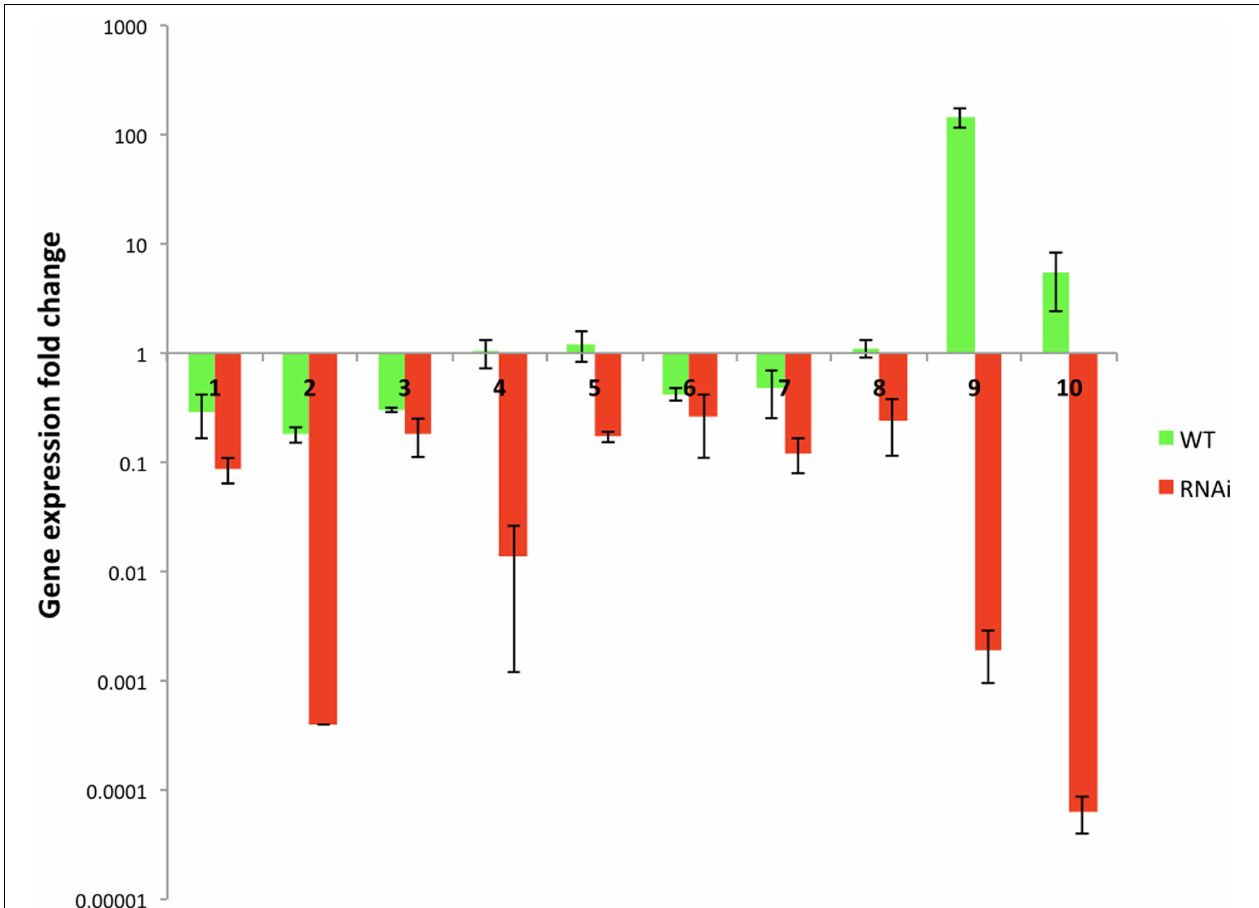
FIGURE 7 | The target genes expression studies of the transformants of RNAi and wild type strain carrying antisense gene library plasmids. Y -axis – logarithmic scale. RNAi strain was Y1662, and the wild type was Y1637, which were newly re-transformed with plasmids. Antisense plasmids: 1 – 2C23 (CAGL0L00157g gene), 2 – 2E5 (CAGL0E00231g gene), 3 – 81E20 (CAGL0G05335g gene), 4 – 6D19 (CAGL0E00539g gene), 5 – 3F3 (CAGL0K11968g gene), 6 – 2I5 (CAGL0G05335g gene), 7 – 82N22 (CAGL0H00891g gene), 8 – 81N8 (CAGL0A01430g gene), 9 – 83K11 (CAGL0H07623g gene), and 10 – 2G7 (CAGL0I11011g gene). The untreated controls were used to calculate gene expression fold change: RNAi and wild type carrying empty vector (P1226). Primer pair ACT1-1 and ACT1-2 was used for ACT1